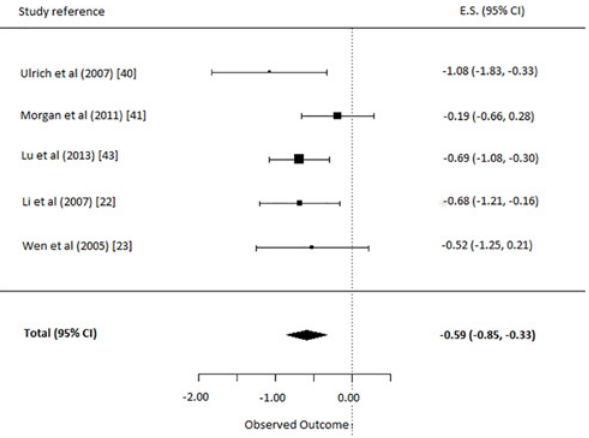
Fig 3. Comparison: depressive symptoms in music therapy versus treatment as usual.